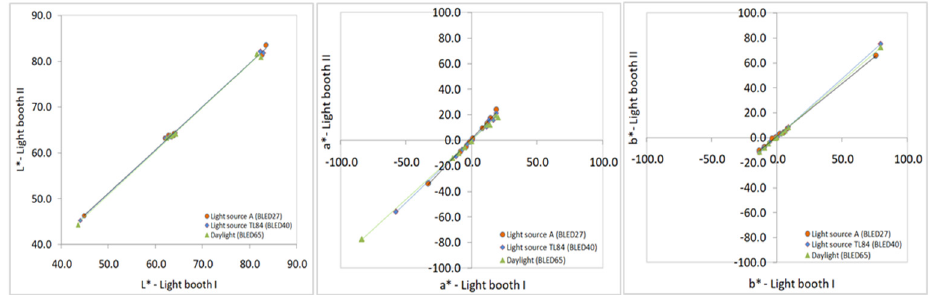
Figure 6. CIE L*a*b* values for different light sources of the two booths. In the figure, BLED65, BLED40, and BLED27 represent the light sources with nominal CCT 6500 K, 4000 K, and 2700 K respectively for light booth I; and Daylight (Simulator D65), TL84 (Tri-band fluorescent tube), and A (Tungsten lamp) represent the light sources with nominal CCT 6500 K, 4000 K, and 2700 K, respectively for light booth II.